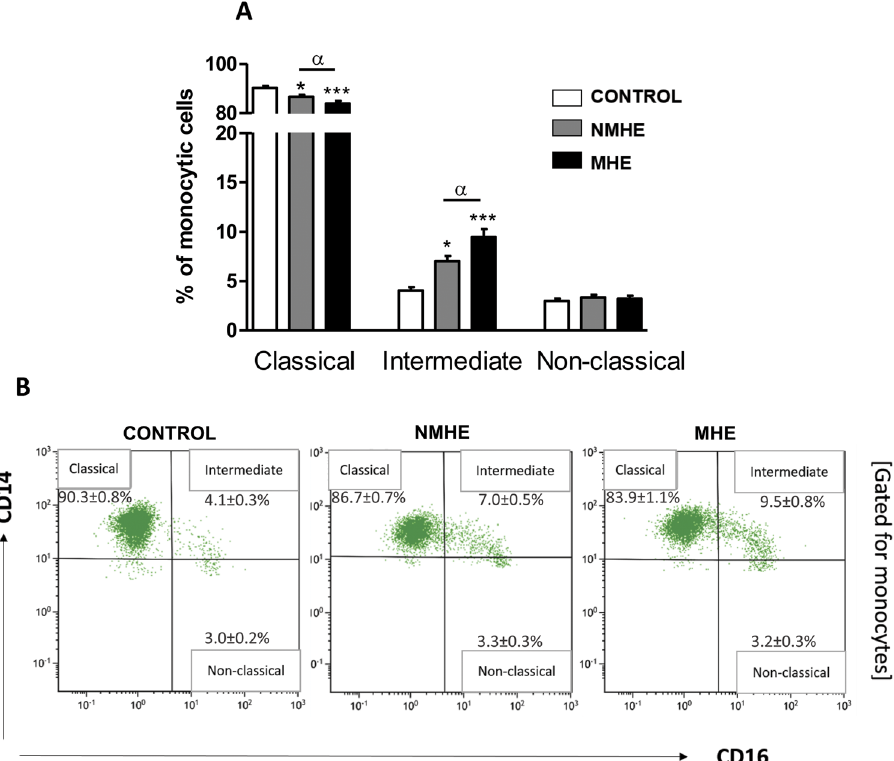
Figure 1. Monocytes populations in peripheral blood. ( A ) Percentage of the three subsets of monocytes over total monocyte cells: classical (CD14 ++ CD16 − ), intermediate (CD14 ++ CD16 + ) and non-classical (CD14 + CD16 ++ ). ( B ) Examples of panels from the cytometer (gated for total monocytes population). Values are the mean ± SEM of the following number of individuals: CONTROL n = 28; without MHE (NMHE) n = 30; with MHE (MHE) n = 40. Values significantly different from controls are indicated by asterisks * . Values significantly different in patients with MHE compared to NMHE are indicated by α . ( * / α p < 0.05; *** p <